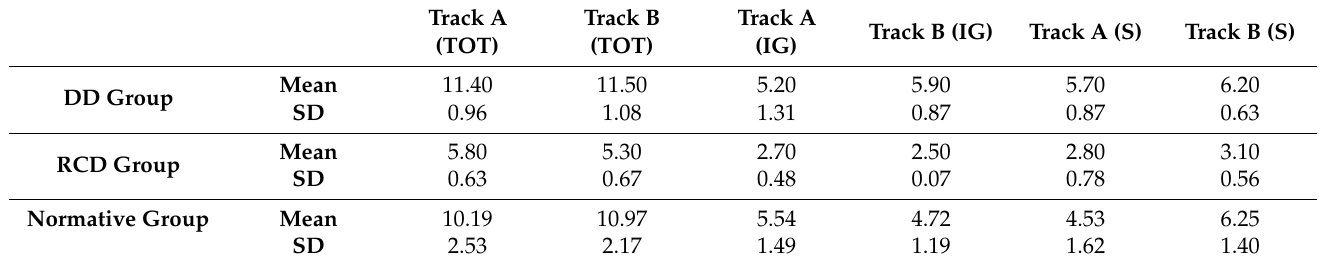
Table 3. Comparison between DD Group, RCD Group, and Normative Group in Tracks A and B (LSC-SUA). Track A Track B (TOT)